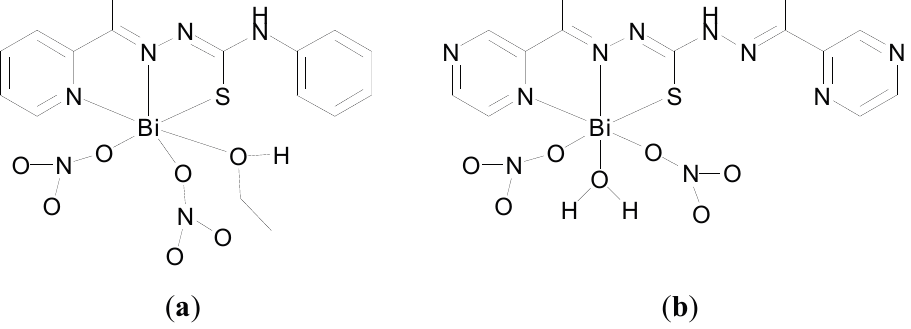
Figure 18. Structure of ( a ) a Bi(III) 2-acetylpyridine N (4)-phenylthiosemicarbazone (HL) complex, [Bi(L)(NO 3 ) 2 (CH 3 CH 2 OH)]; ( b ) a Bi(III) bis(2-acetylpyrazine) thiocarbonohydrazone (H 2 L) complex, [Bi(HL)(NO 3 ) 2 (H 2